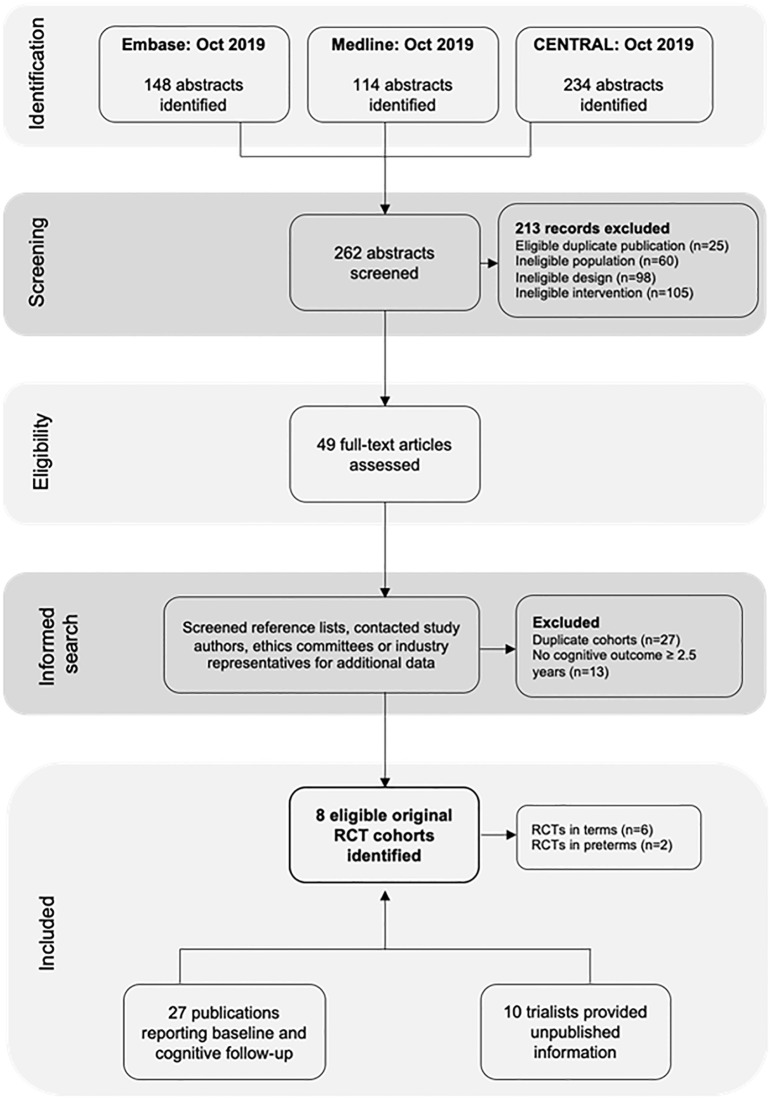
Study selection process.